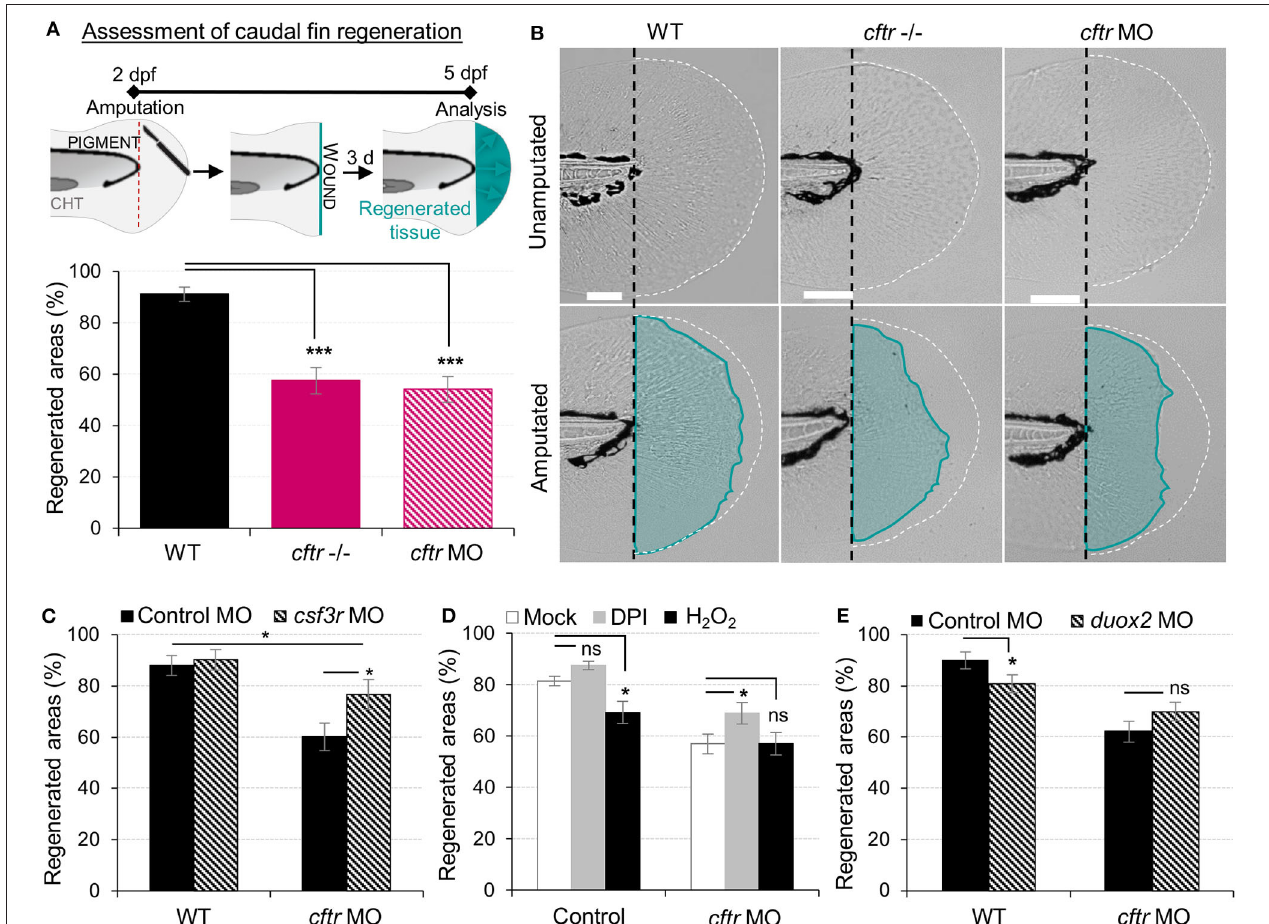
FIGURE 4 | Neutrophilic response in CF hampers tissue repair in vivo. (A,B) Tail fin regeneration assessment in WT, cftr –/– and cftr MO zebrafish. Two dpf embryos were tail fin amputated then the potential of tail fin regeneration is evaluated by measuring regenerated fin areas at 3 dpi (blue). (A) Measurement of regenerated fin areas ( n = 30, one-way ANOVA with Dunnett’s post-test). (B) Representative imaging of injured tail fin at 3 dpi (scale bars, 200 µ m). (C) Selective ablation of neutrophils has been carried out in WT and CF animals by injecting csf3r -MO. Measurement of regenerated fin areas in the presence or absence of neutrophils ( n = 21, one-way ANOVA with Tukey post-test). (D) TgBAC(mpx:EGFP)i114 larvae were pretreated with DPI or H 2 O 2 prior to tail fin amputation procedures, then injured and immediately put back in treatments for 4h. Regenerated fin areas are measured at 3 dpi ( n = 21, one-way ANOVA with Dunnett’s post-test). (E) Inhibition